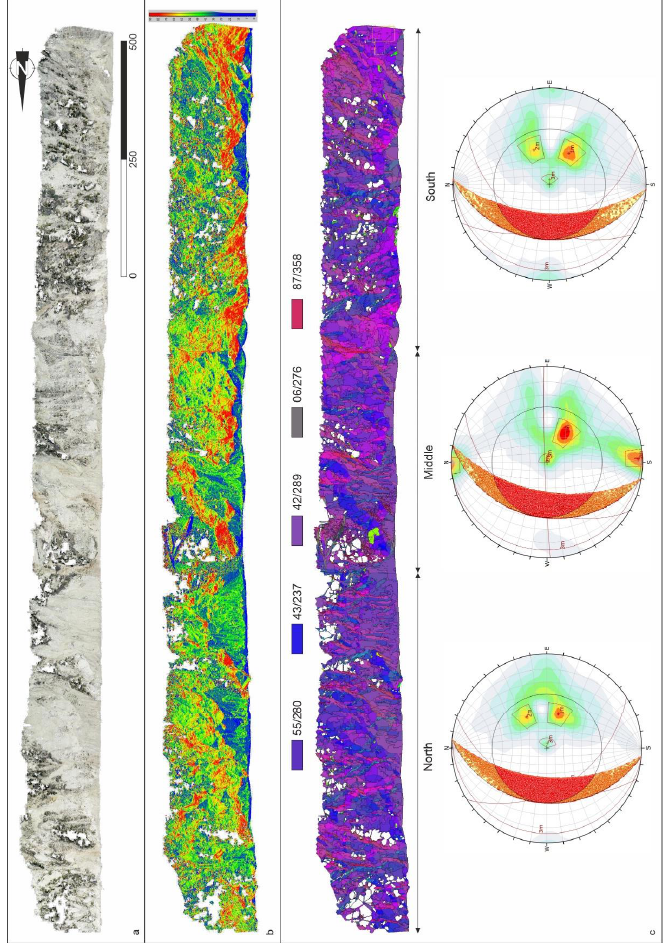
Figure 7. ( a ) The point cloud of the cliff uphill from the Egremnoi beach, cleaned from the noise caused by the vegetation, which might alter its steep topography. Classification of the extracted facets according to their calculated dip in degrees ( b ) and each one’s dip direction that is color-coded regarding the statistical analysis ( c ). The cliff was segmented into three segments (North, Middle and South) and below each one, the wedge-sliding kinematic analysis is presented.